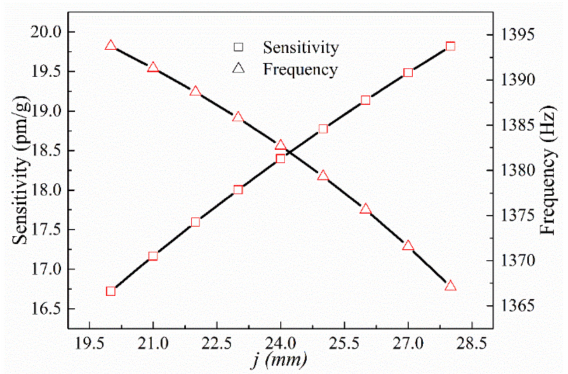
Figure 8. Sensitivity and natural frequency in the z-direction as a function of j